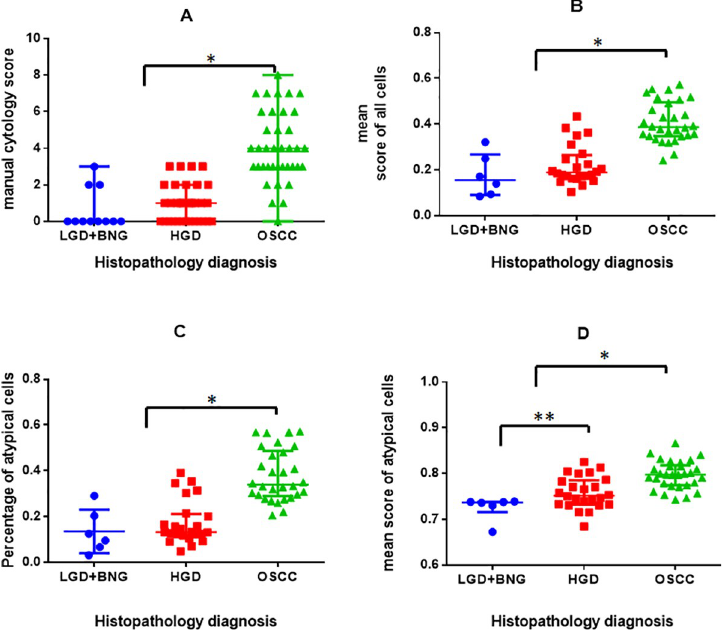
Fig 4. Distribution of manual and ANN cytology scores. Box and whisker plot represent (a) cytology score of direct microscopy method (n = 82), OSCC (4.08 ± 1.92) score shows significant difference from ( � p < 0.005) LGD (0.63 ± 1.12) and HGD lesions (1 ± 1.05). ANN Scoring (n = 60): The mean score of all cells (b) shows statistical significance between dysplasia (HGD, LGD) and OSCC (0.40 ± 0.08, � p < 0.005), but does not show significant difference between LGD (0.17 ± 0.09) and HGD (0.21 ± 0.08). The percentage of atypical cells (c) OSCC (0.38 ± 0.11) shows significant difference from dysplasia ( � p < 0.005) but not show significant between HGD (0.17 ± 0.09), and LGD (0.17 ± 0.09). The mean atypical score of atypical cells (cells having score > 0.05) (d) in each patient demonstrating statistical significance between dysplasia (HGD, LGD) and OSCC (0.71 ± 0.02, � p < 0.005) and also between LGD (0.78 ± 0.03) and HGD (0.76 ± 0.03) ( �� p < 0.05). The mean and standard deviation values are provided in brackets.